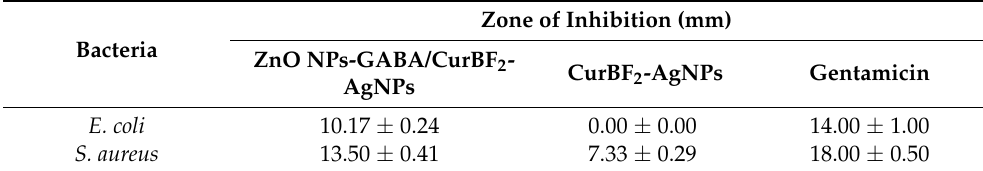
Figure 7. Antimicrobial activity of (i) CurBF 2 -AgNPs (ii) ZnO-GABA/CurBF 2 -AgNPs, (iii) gentamicin, (iv) DI water against ( a ) E. coli and ( b ) S. aureus . Table 2. Zone of inhibition in millimeters of ZnO NPs-GABA/CurBF 2 -AgNPs, CurBF 2 -AgNPs, and standard drug against Gram-negative and Gram-positive bacteria.